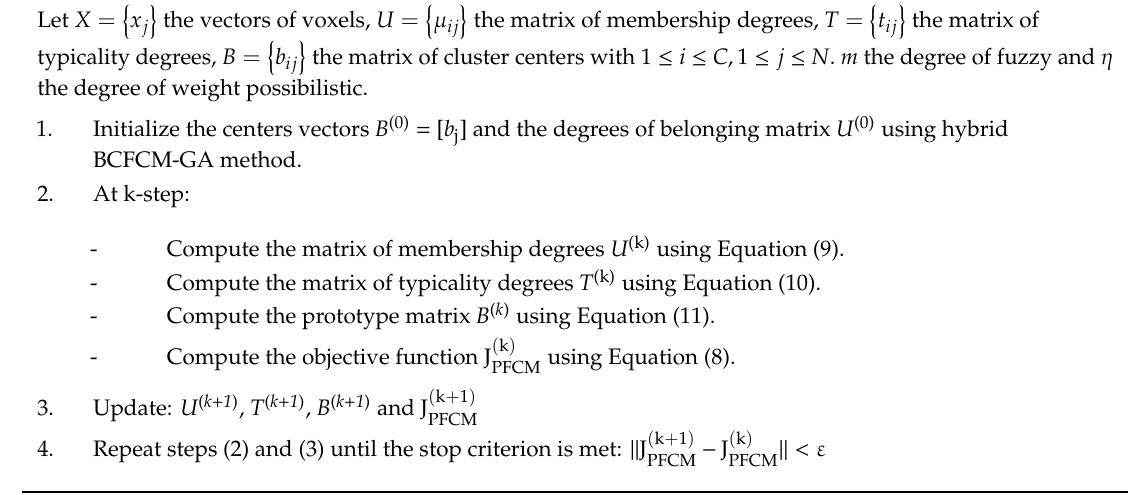
Algorithm 2: PFCM